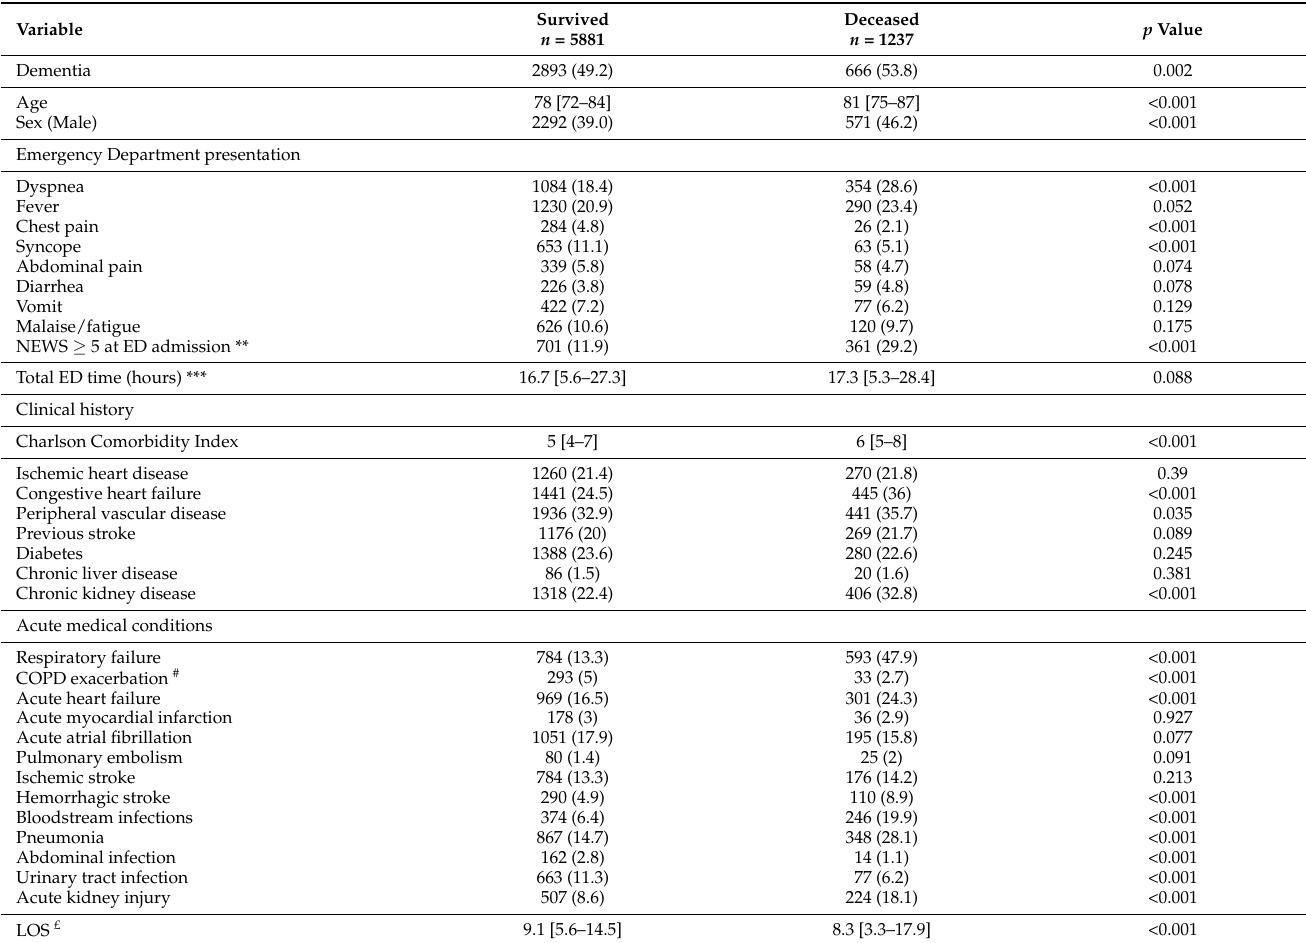
Table 3. Population demographics of adults ≥ 65 years admitted to the Emergency Department (ED) and subsequently hospitalized. Comparison with respect to all cause in-hospital death.